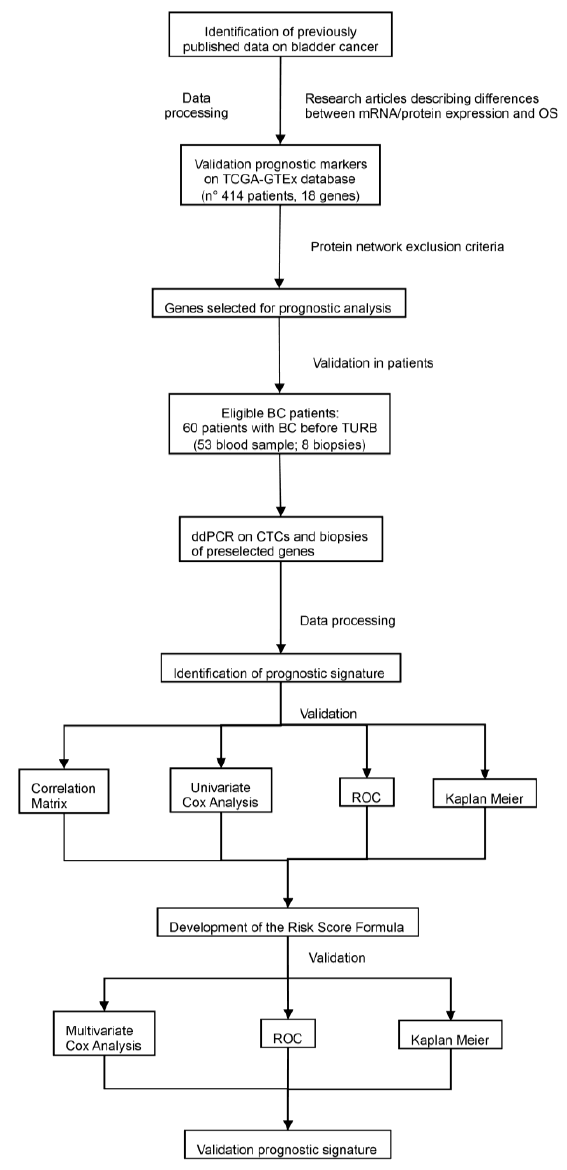
Figure 1. The flowchart of the data processing, analysis, and validation in the current study.